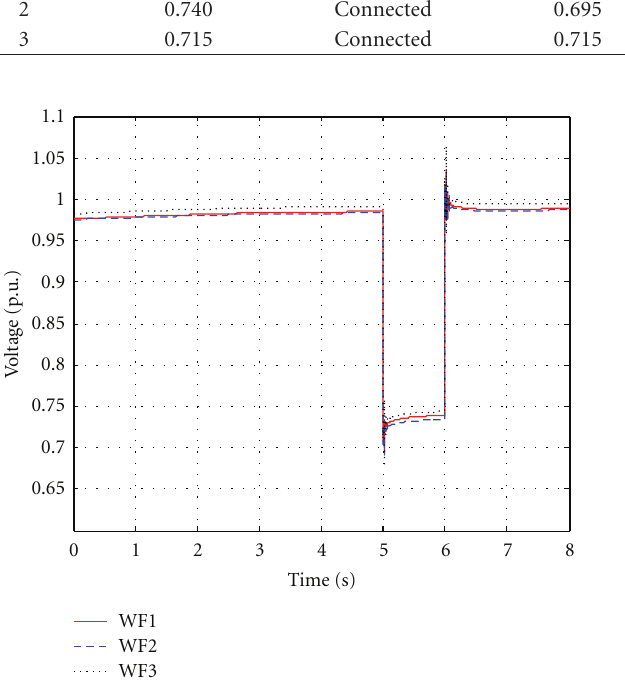
Figure 7: Voltage at the PCC.